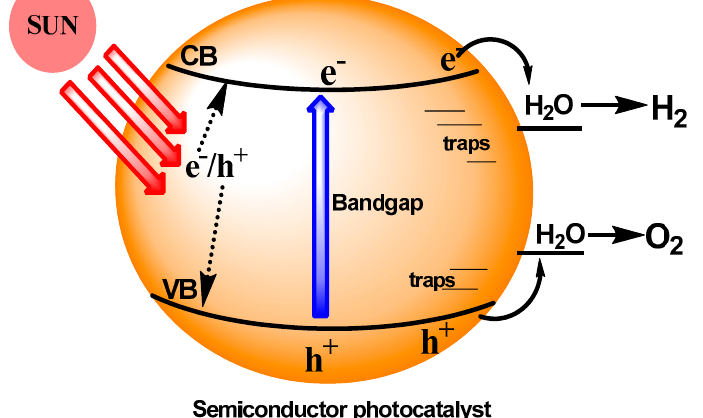
Figure 9. Schematic illustration of a photocatalytic semiconductor nanoparticulate system in converting light energy into a solar fuel (H 2 ) from the water splitting process.